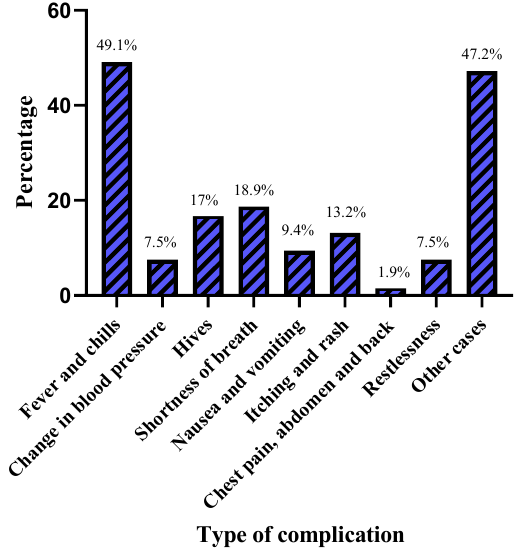
Figure 3. Frequency of Complications After Transfusion in Kashani